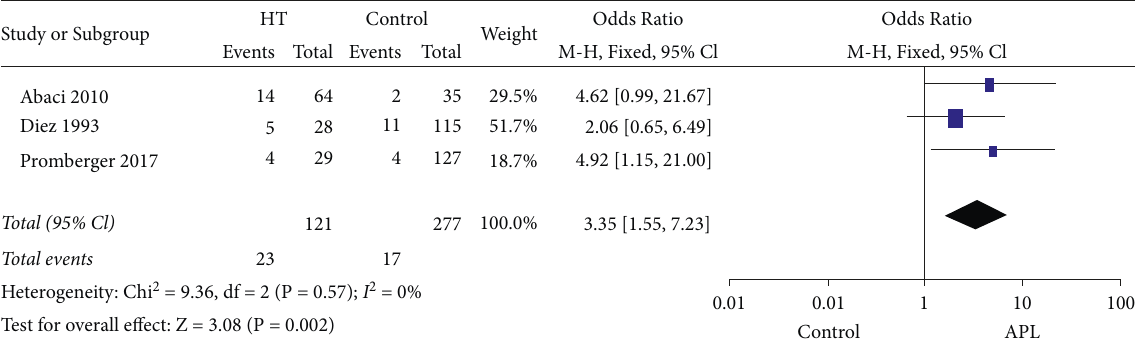
Figure 4: Forest plots for the prevalence of positive APL in HTpatients compared with healthy controls. HT: Hashimoto’s thyroiditis; APL: antiphospholipid antibodies; CI: confidence